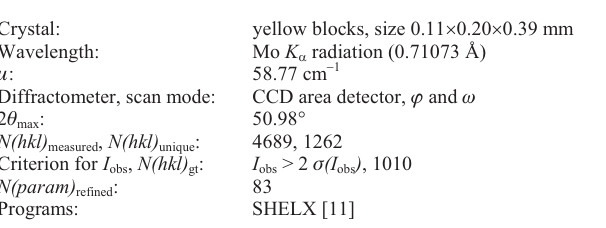
Table 1. Data collection and handling.